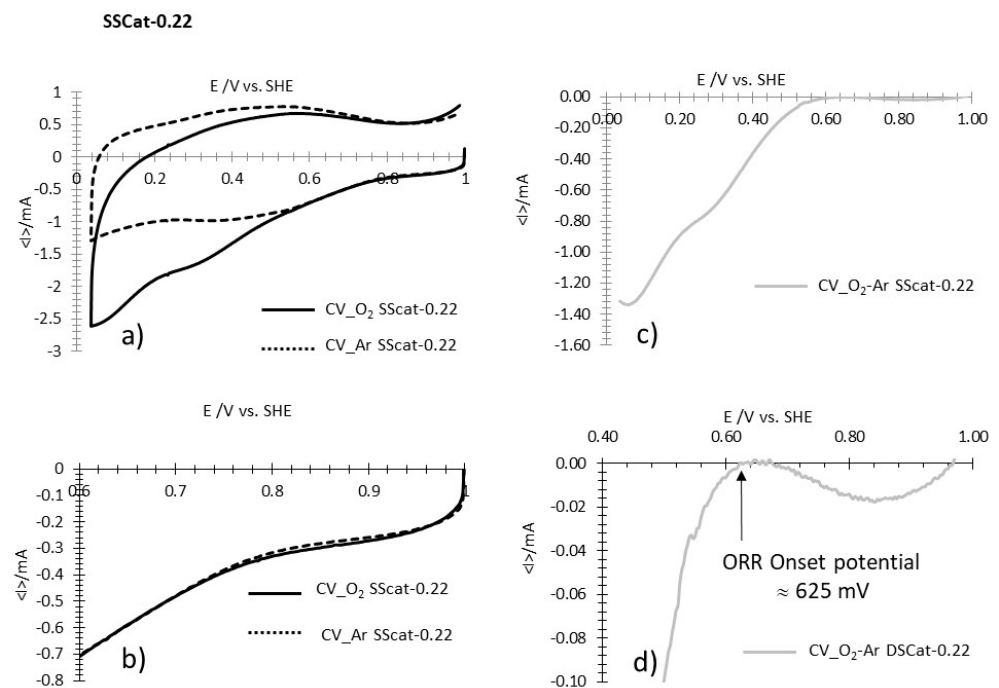
Figure A3. Example of determination of ORR onset potential for SSCat-0.22. ( a ) CVs recorded at 5mV · s − 1 in O 2 saturated HClO 4 1M (CV_O2 SSCat-0.22) and in Argon saturated HClO 4 1M (CV_Ar SSCat-0.22). ( b ) Enlargement of a) in the potential region of the ORR onset potential. ( c ) CV resulting from the difference between CV_O 2 SSCat-0.22 and CV_Ar SSCat-0.22. ( d ) Enlargement of c) in the potential region of the ORR onset potential, showing its determination (vertical arrow).